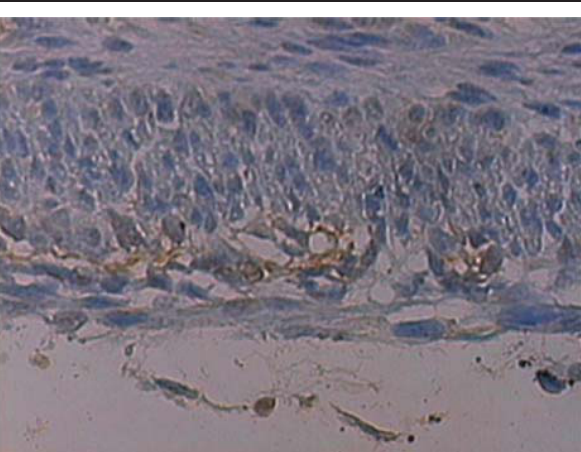
FIGURE 3 – Photomicrography of the terminal intestine of the ARM group with S-100 protein